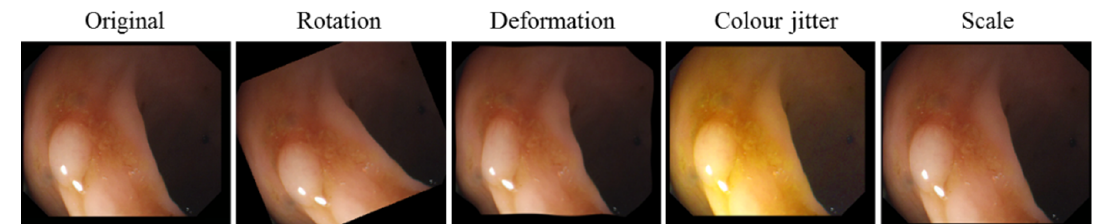
Figure 5. An example of an standard definition (SD) image augmentation using rotation, local deformation, color jitter, and scale.